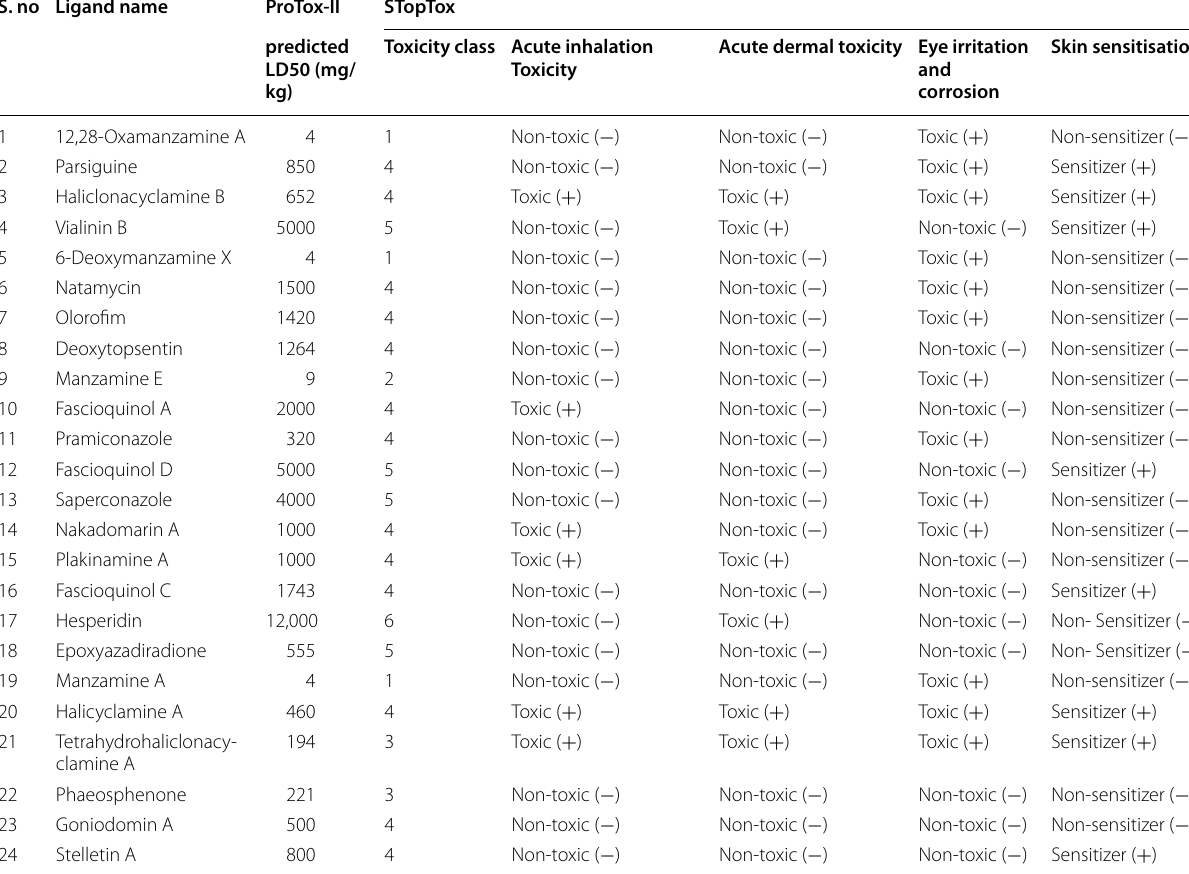
Table 8 Toxicity report carried out using ProTox-II and STopTox server for top ligand